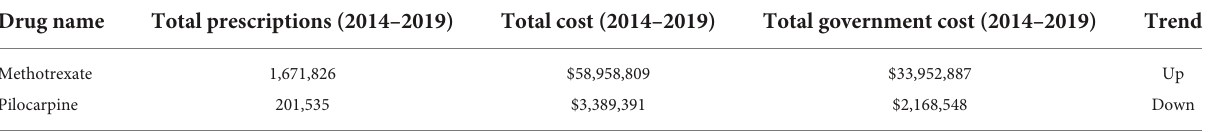
TABLE 2 PBS data (2014–2019) showing prescription numbers and costs for members of the probable category of drugs associated with